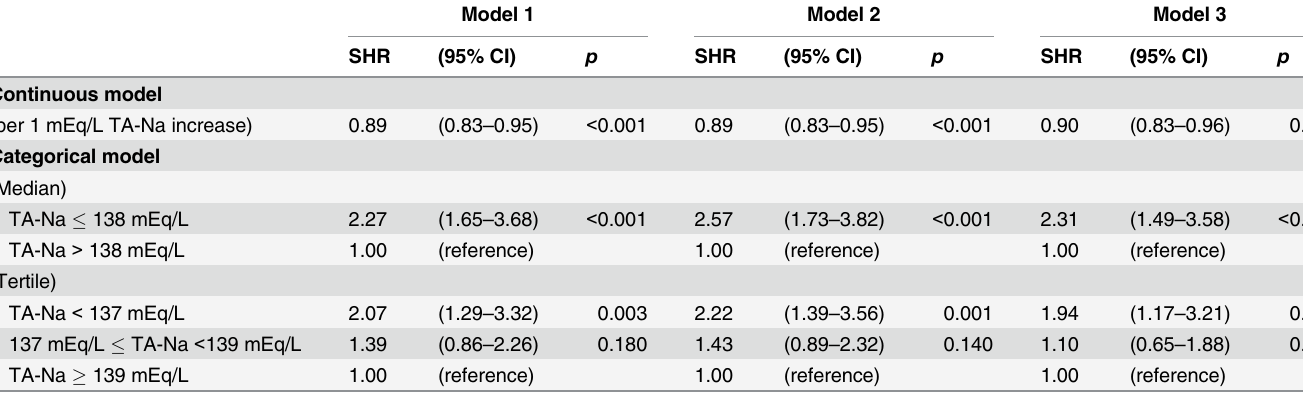
Table 2. Multivariable Cox regression analyses for the risk of new-onset cardiovascular events.